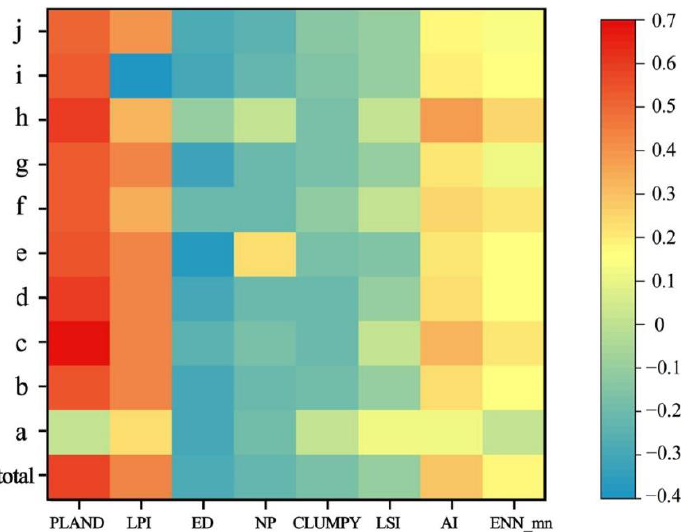
Figure 12. Correlation between landscape patterns index and ecosystem service value (ESV). Ab- breviations: a (food production), b (material production), c (gas regulation), d (climate regulation), e (purified environment), f (hydrological regulation), g (soil conservation), h (main nutrient cycle), I (biodiversity), j (aesthetic landscape).